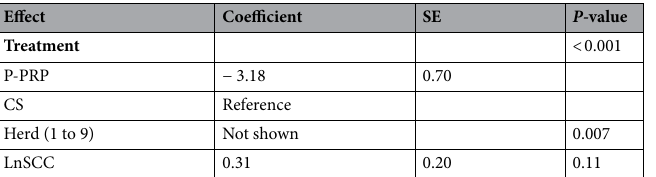
Table 3. Coefficients and standard error (SE) of the logistic regression model for evaluating the effect of intramammary treatments (10 mL of P-PRP and 75 mg of CS for three consecutive milkings) on the probability of bacteriological cure in cows with subclinical mastitis caused by Gram-positive pathogens. CS cefquinome sulfate, LnSCC natural log of somatic cell count, P-PRP pure platelet rich plasma, SE standard error.